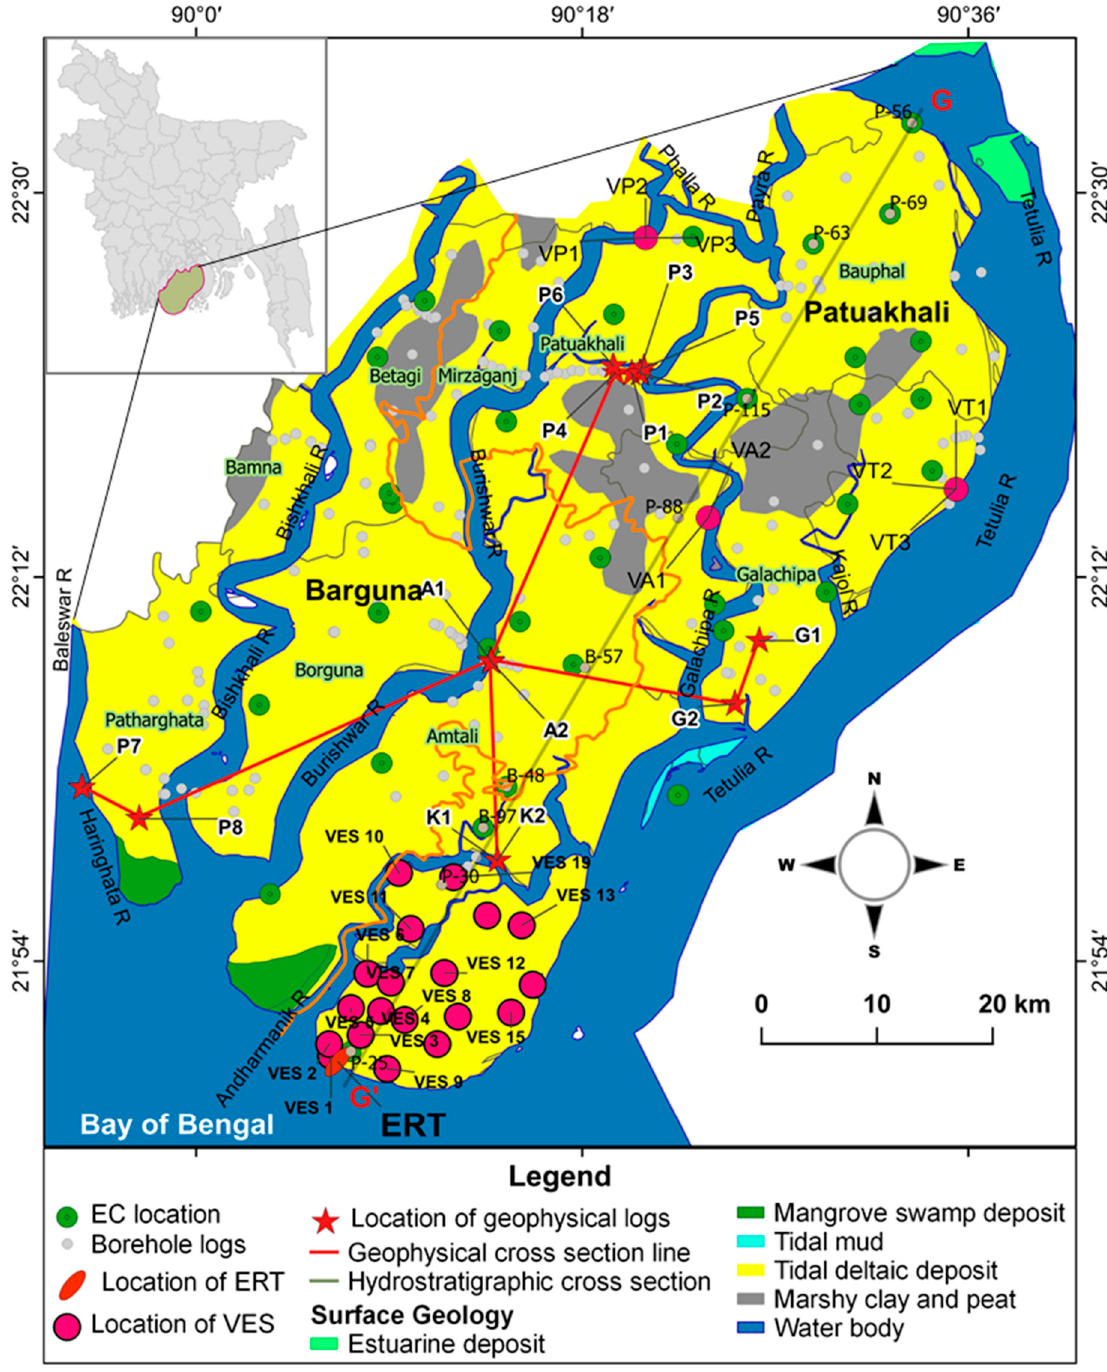
Figure 1. Geological map of the study area with location of the boreholes, geophysical borehole logs, VES, ERT, and EC. The solid line G–G ′ is the hydrostratigraphic cross-section line.